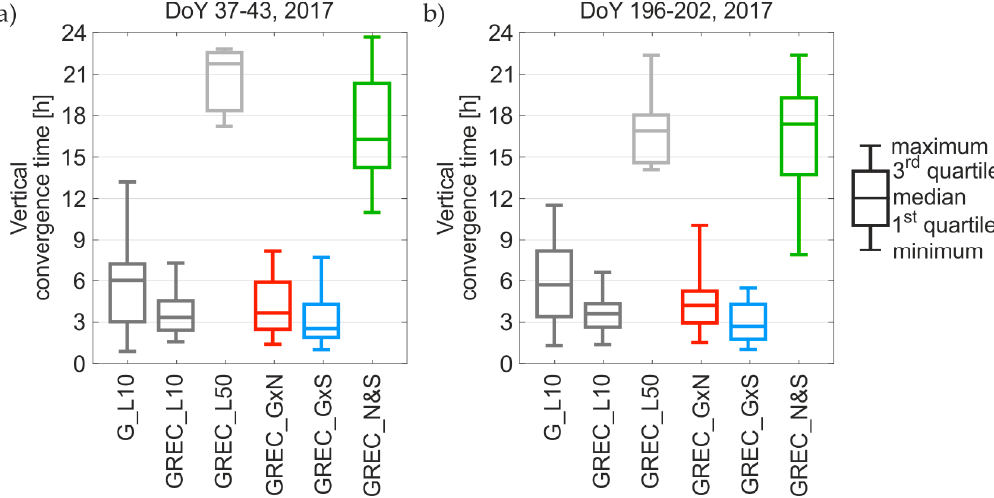
Figure 8. Convergence time to the level of 0.01 m for horizontal components.